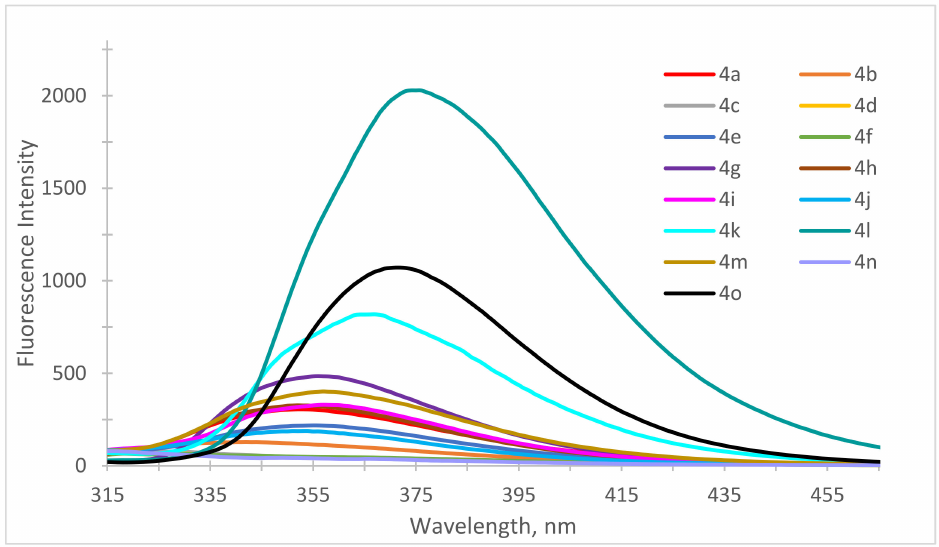
Figure 7. Fluorescence spectra of 4a – 4o in dichloromethane at room